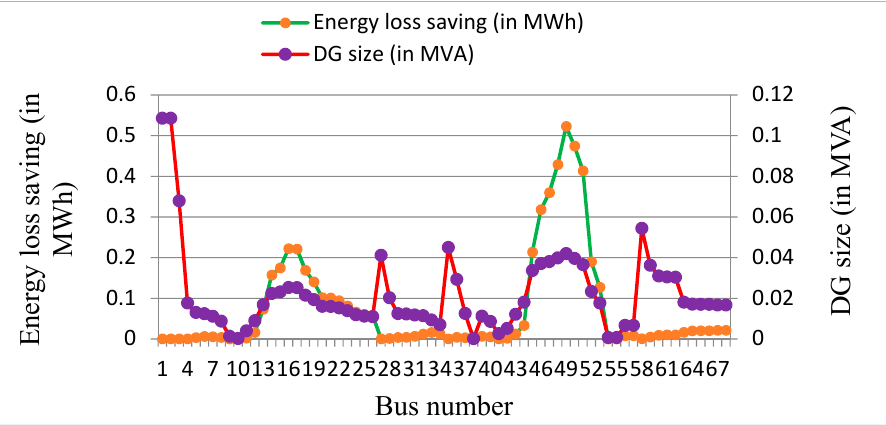
Figure 10. Loss saving of active energy components with the subsequent size of DGs (in MVA) for different nodes for the third iteration with DGs placed at nodes 50, 17 and 11 for IEEE 69-bus system.